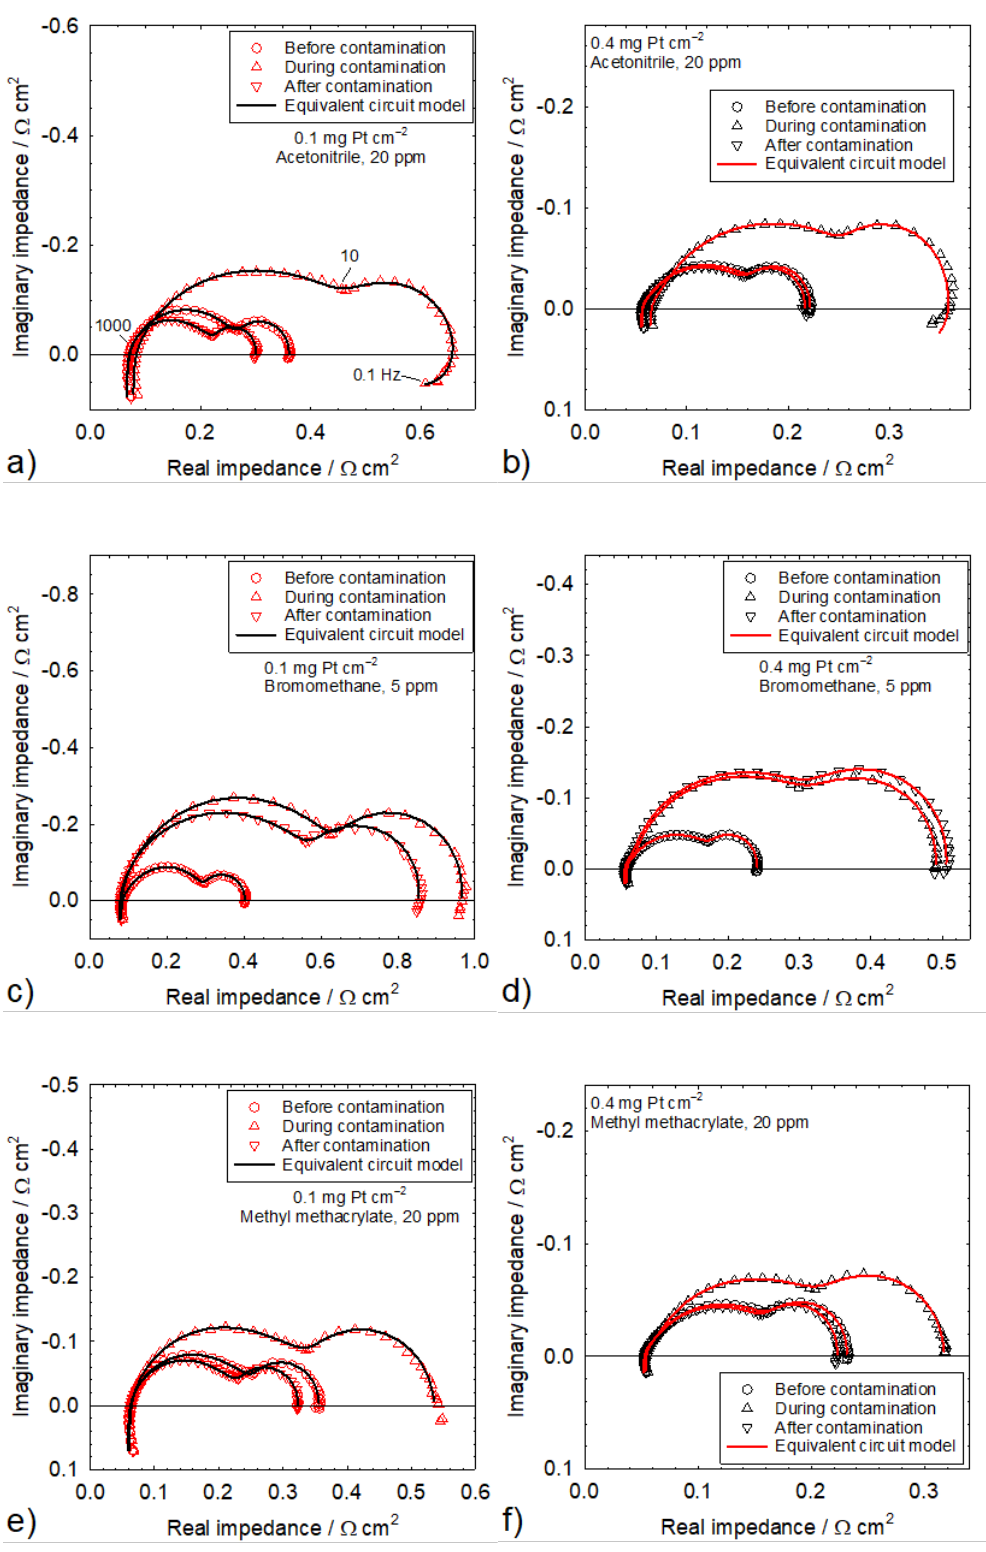
Figure 2. Impedance spectra before, during, and after contamination by acetonitrile in ( a ) and ( b ), bromomethane in ( c ) and ( d ), and methyl methacrylate in ( e ) and ( f ) for Pt catalyst loadings of 0.1 mg cm −2 in ( a ), ( c ), and ( e ), and 0.4 mg cm −2 in ( b ), ( d ), and ( f ).